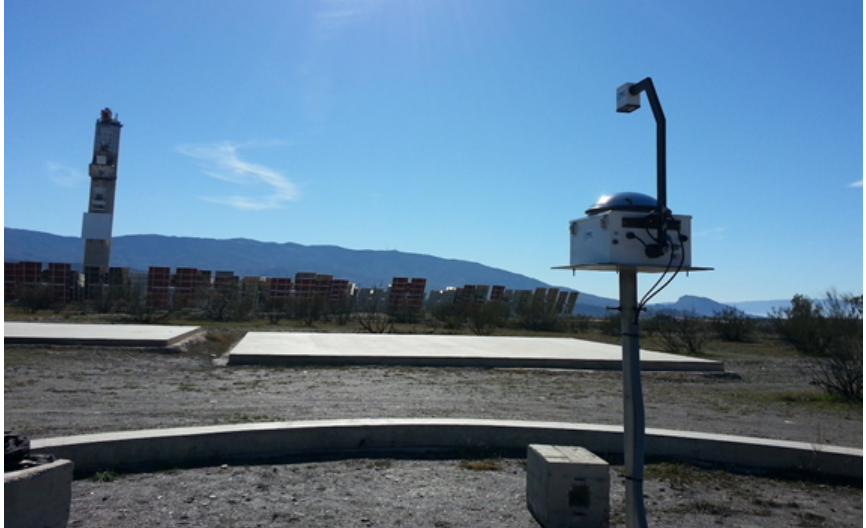
Figure 1. The TSI-880 sky camera placed at the northern end of the PSA site.